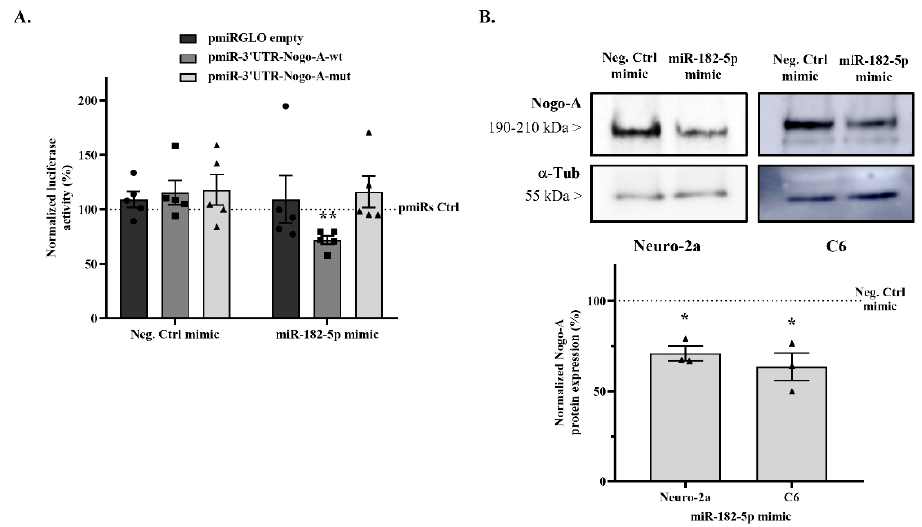
Figure 3. miR-182-5p mimic regulates Nogo-A expression. ( A ) Luciferase reporter activity of either miR-182-5p or negative control mimics on pmiRGLO-3 ′ UTR-Nogo-A-wt, pmiRGLO-3 ′ UTR-Nogo- A-mut, and empty pmiRGLO. Bar graphs show mean ± SEM of the firefly/Renilla emission ratio normalized to the corresponding pmiRGLO without mimic co-transfection (pmiRs control) in Neuro-2a cells (two-tailed paired t-test, T 4 = 4.789, p = 0.0087, n = 5 independent experiments). ** indicates a p -value < 0.01. ( B ) Representative immunoblot of Nogo-A and the load-control α -tubulin protein expression in Neuro-2a cells and C6 cells transfected with either miR-182-5p or negative control mimics. Bar graphs show the mean ± SEM of three independent experiments; Nogo-A expression was normalized by the respective α -tubulin expression, taking negative control values as control levels. MiR-182-5p mimic transfection showed statistical reduction in the Neuro-2a cell line (two-tailed paired t-test, T 2 = 7.291; p = 0.0183) and the C6 cell line (two-tailed paired t-test, T 2 = 4.755; p = 0.0415). * indicates a p -value < 0.05.